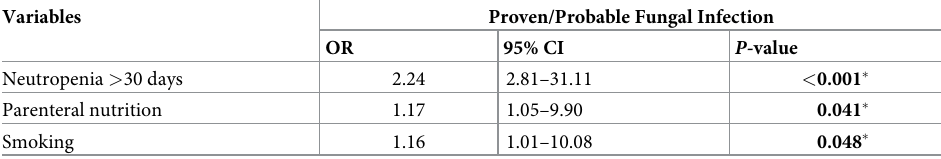
Table 4. Multivariate analysis of the risk factors for proven/probable invasive fungal infection during induction chemotherapy among Taiwanese patients with newly diagnosed acute myeloid leukemia.